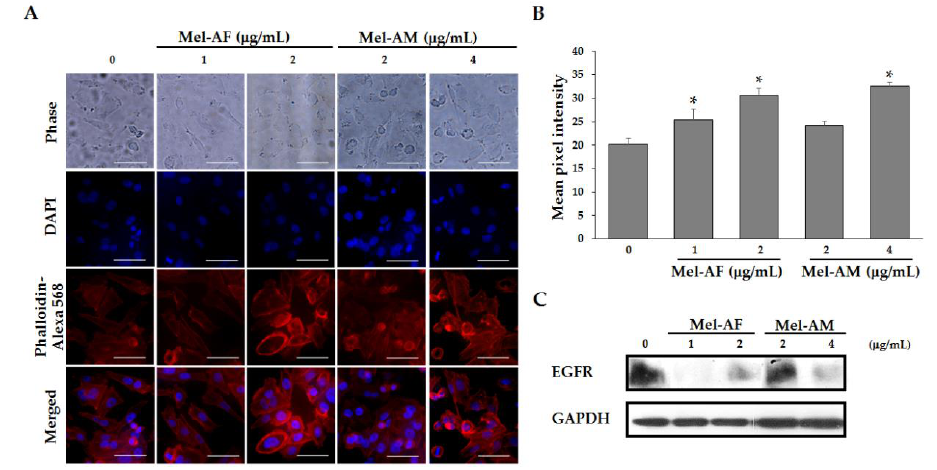
Figure 7. Accumulation of actin stress fibers and suppression of EGFR expression upon Mel-AF treatment for 2 h. ( A ) The treated cells were fixed and the arrangement of actin cytoskeleton was investigated by F-actin staining (red). Images reveal that the cells that were treated with Mel-AF (or Mel-AM) formed abundant amounts of stress fibers beneath the cell membrane when compared with untreated cells. Scale bar, 50 µm. ( B) F-actin levels were quantified by pixel intensity. ( C ) Expression of EGFR in Mel-AF (or Mel-AM) treated cells was investigated by western blot analysis with specific antibodies. GAPDH was used as an internal control to show equal protein loading. * p < 0.05 was determined by one-way analysis of variance.